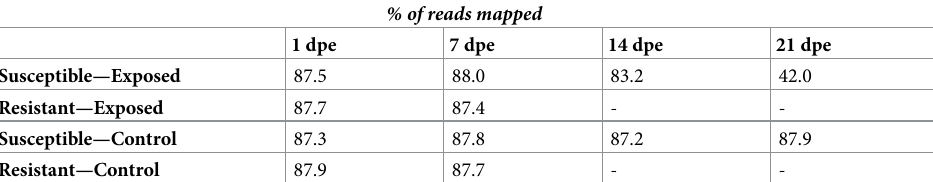
Table 2. Percentage of sequencing reads that mapped to the reference genome at each timepoint.